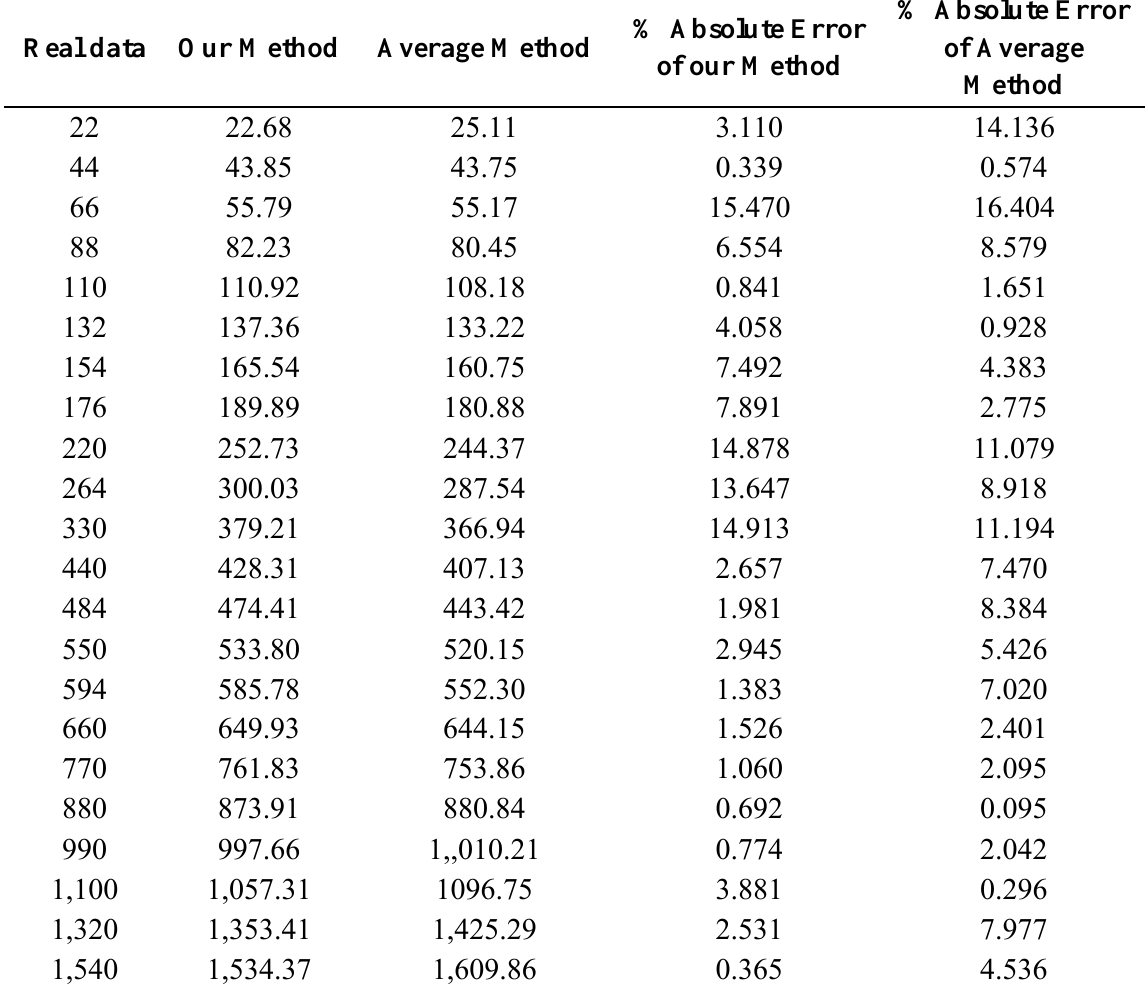
Table 4. Experimental results of acetone.